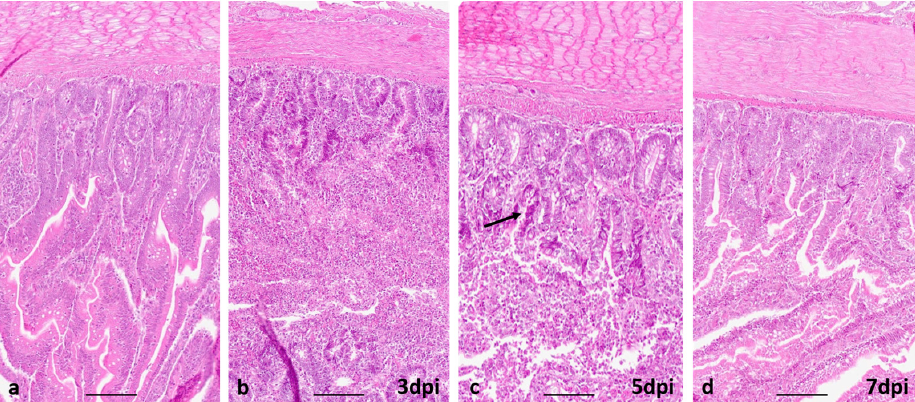
LT_2-Br1 group of birds, according to a two-way ANOVA with Bonferroni post hoc testing. The infected chickens shed viruses via oropharyngeal and cloacal routes. Viruses were detected in the oropharyngeal swabs between 1 and 10 dpi and in cloacal swabs between Figure 4 . Section of lung of chickens ( a ) uninfected, no lesions, ( b – f ) infected with LPAI, ( b ), mild 3 and 10 dpi (Figure 6). No significant differences were observed in terms of viral RNA congestion, ( c ) congestion with edema, ( d ) severe congestion, edema and collapsing of alveoli, ( e , f ) load and kinetics of dissemination between the two studied virus isolates (LT_2 and LT_56) almost normal appearance of lung, comparable to control ( a ). H & E stain, bar: ( a – d , f ) = 50µm; ( e ) = 20µm . in both infected chicken (Sonali and broiler) groups.